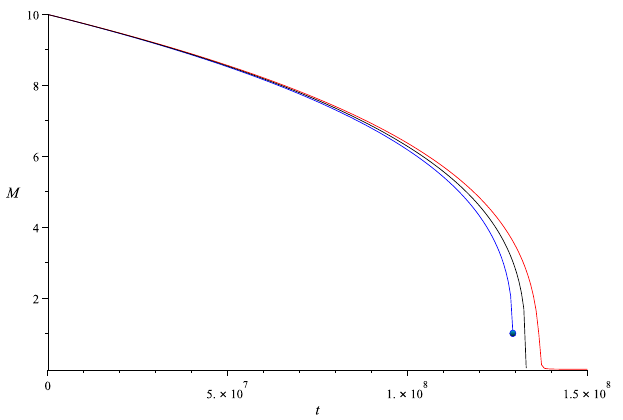
Figure 2 . Mass evolution of Schwarzschild black holes with no GUP correction (black, middle curve), positive GUP correction (blue, left curve), and negative GUP correction (red, right curve). The positive GUP correction leads to a remnant in (cid:12)nite time, while negative GUP correction yields in(cid:12)nite lifetime. These contrast with the usual case without GUP correction, in which the black hole completely evaporates in (cid:12)nite